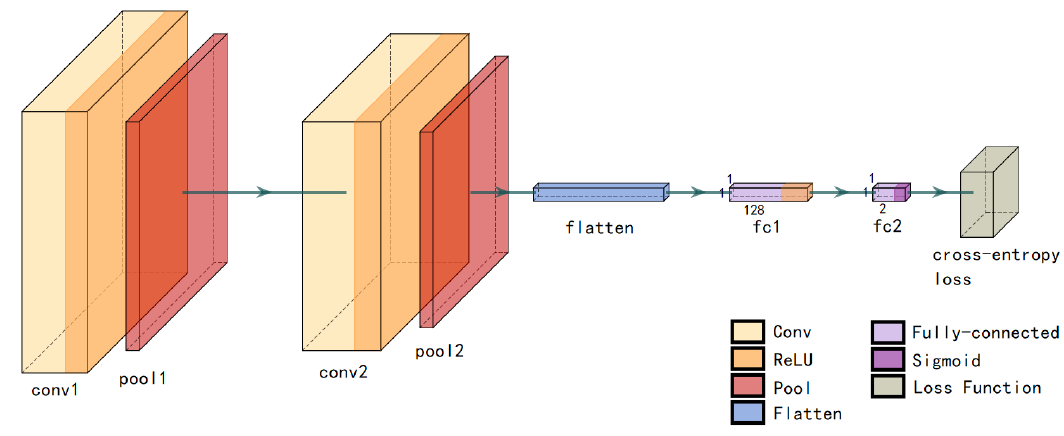
Figure 2. Structure of baseline model.